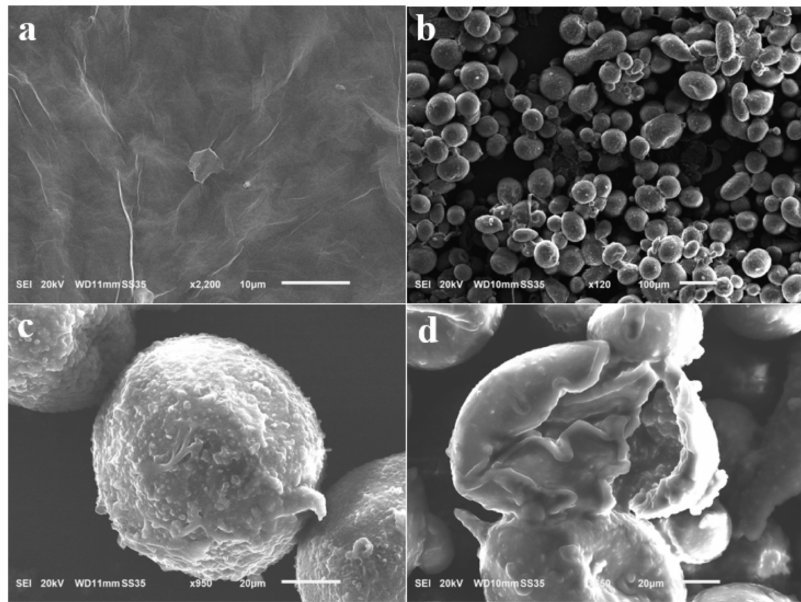
Figure 3. SEM image of GO ( a ) and C-O/W microcapsules ( b – d ).